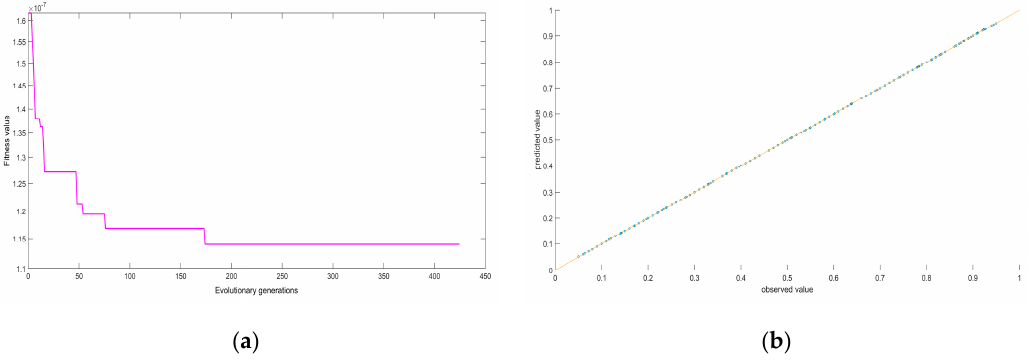
Figure 4. ( a ) The curve of fitness values over evolutionary generation; ( b ) Scatter plot of training dataset for observed value and predicted value. Table 2. The performance statistics of least squares support vector machine (LSSVM) model and radial basis function (RBF) network model during training and testing periods.